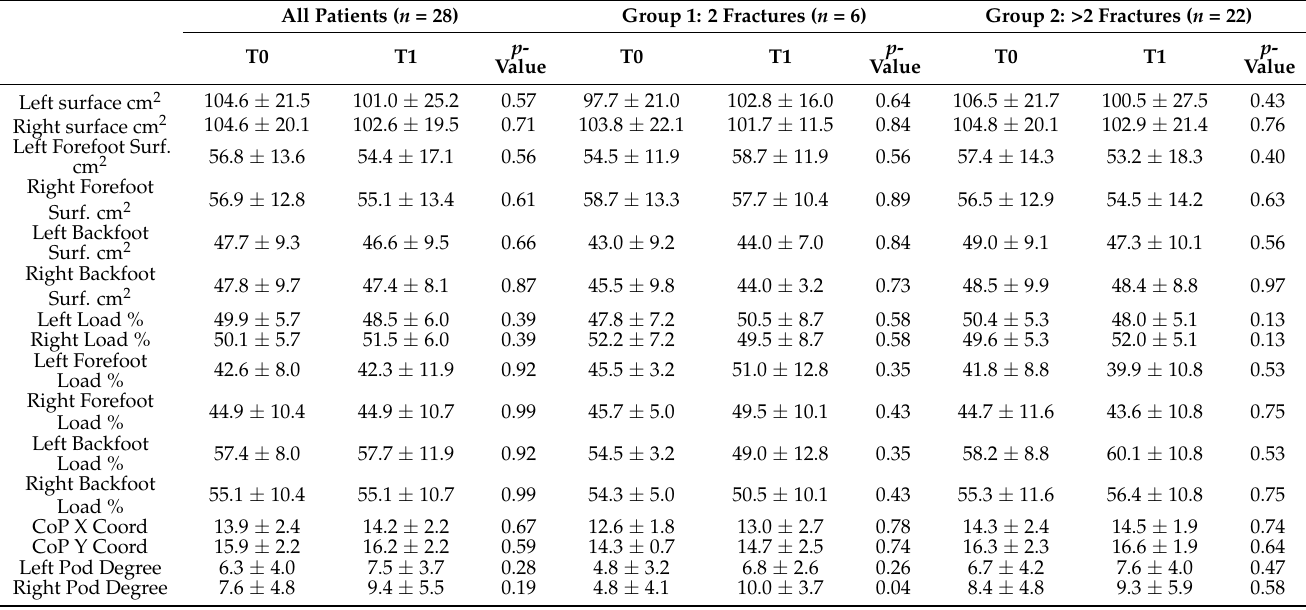
Table 2. Posturographic analysis.